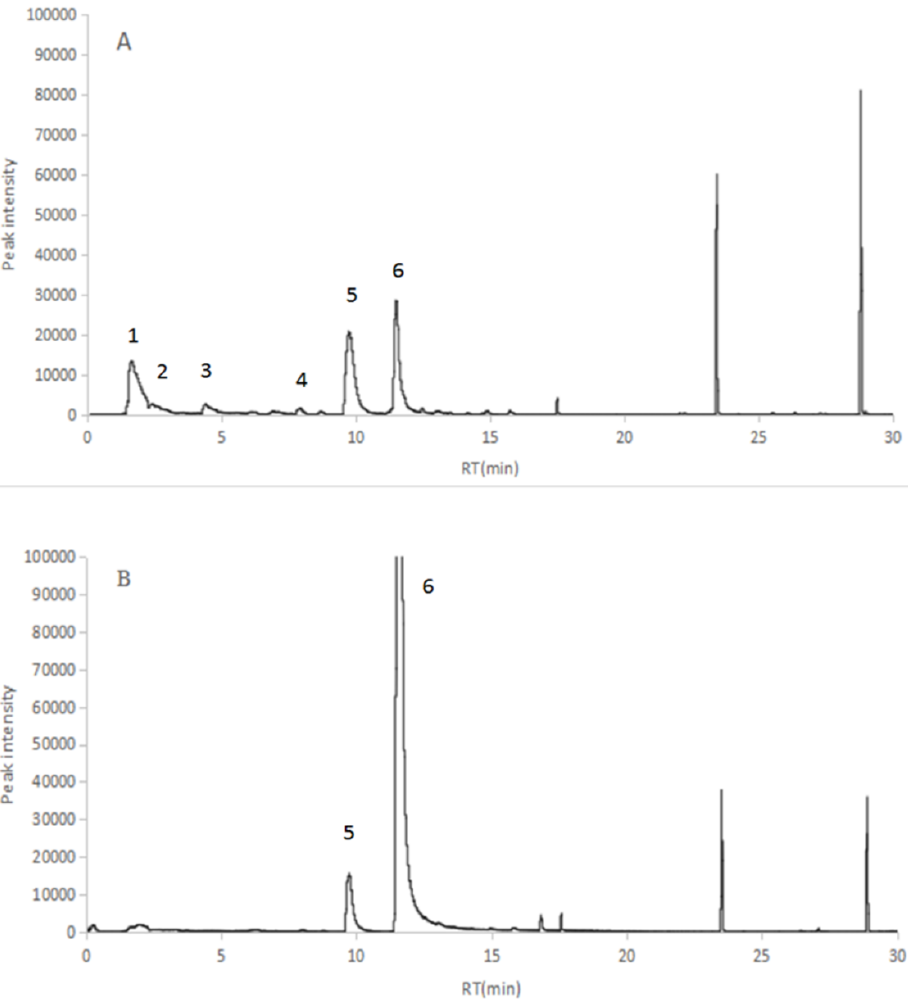
Figure 2. Chromatograms of VOCs in the TIC mode via CAR / DVB extraction. ( A ) Culture of V. dokdonensis 1A00493; ( B ) 2216E medium. Table 2. Contact nematicidal activity of the VOCs against M. incognita